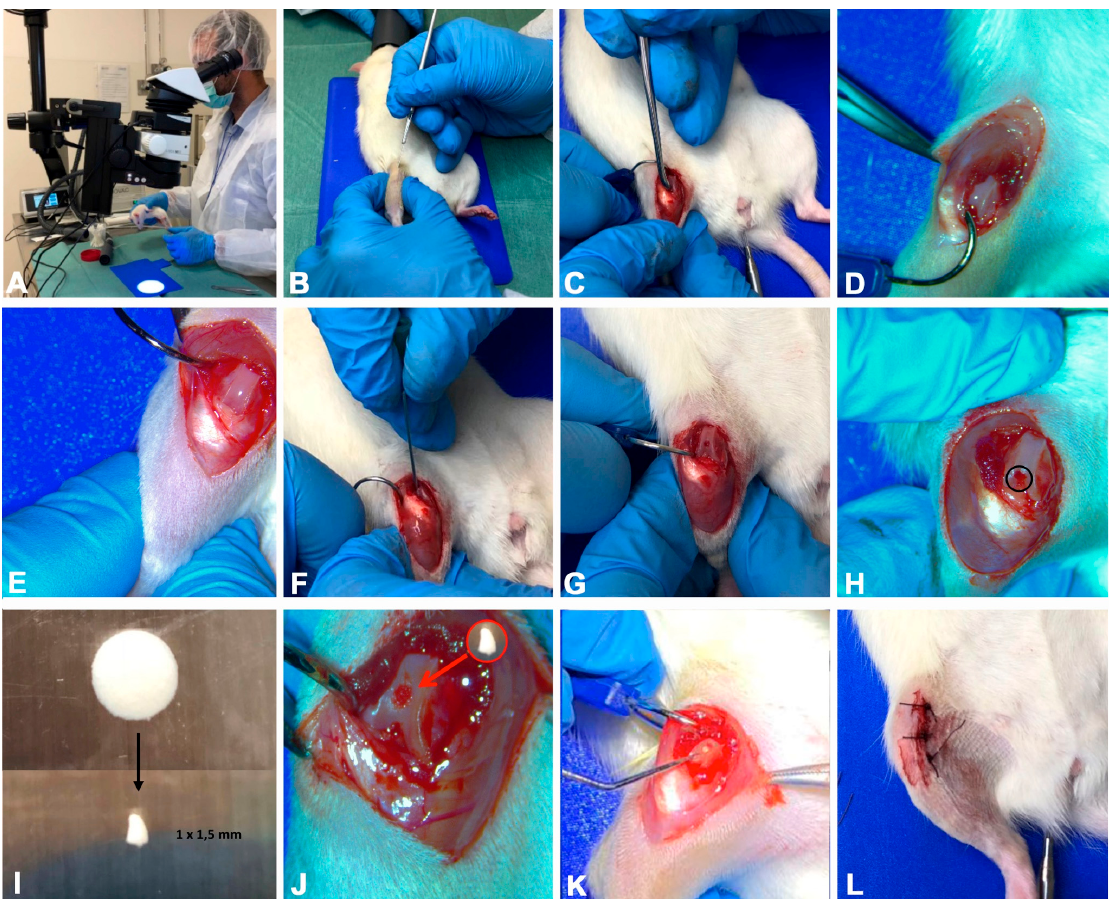
Figure 6. The photographs representing the surgical procedure performed to create defects (ACL induction) and to implant a collagen I-based scaffold. ( A ) total anaesthesia induction; ( B ) knee joint preparation for the incision; ( C–E ) vertical incision through the skin and articular capsule along the medial border and lateral displacement of the patella; ( F–H ) hole formation at the level of the femoropatellar groove in both ACL and ACL-S groups; ( I ) collagen I-based scaffold preparation and cutting; ( J ) collagen I-based scaffold implantation into the hole in the ACL-S group only; ( K , L ) patella replacement and the articular capsule and skin suture.